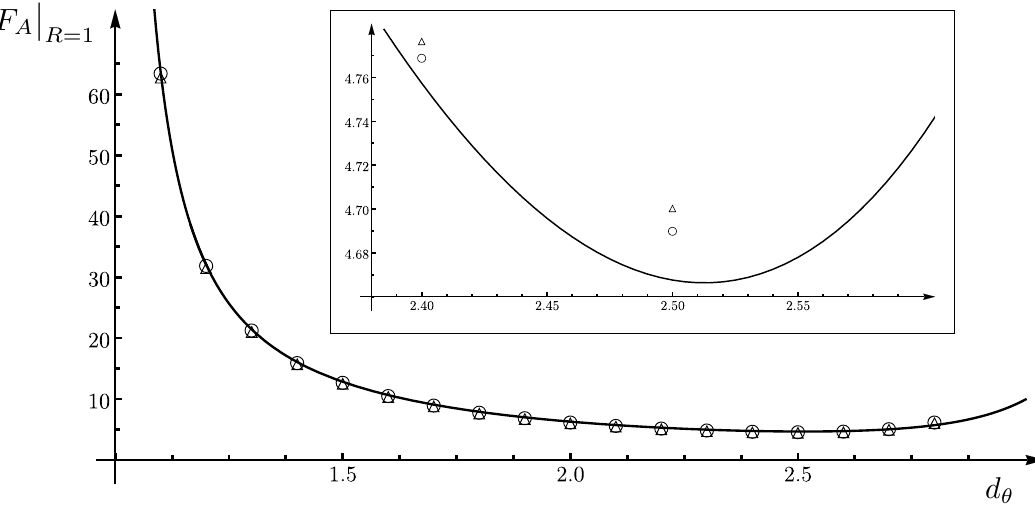
Figure 2 . Finite term F A in terms of 1 < d (cid:18) < 3 for minimal surfaces anchored to a disk of radius R = 1 in the hvLif 4 geometry (2.21) at t = const. The solid line is found by (cid:12)rst solving numerically (with Wolfram Mathematica) the di(cid:11)erential equation (5.15) and then plugging the resulting radial pro(cid:12)le into (5.17). The data points labelled by the empty circles and the empty triangles have been obtained with Surface Evolver through the two formulas in (5.20) respectively. The inset contains a zoom close to the minimum of the curve, that corresponds to ( d (cid:18) ; F A )